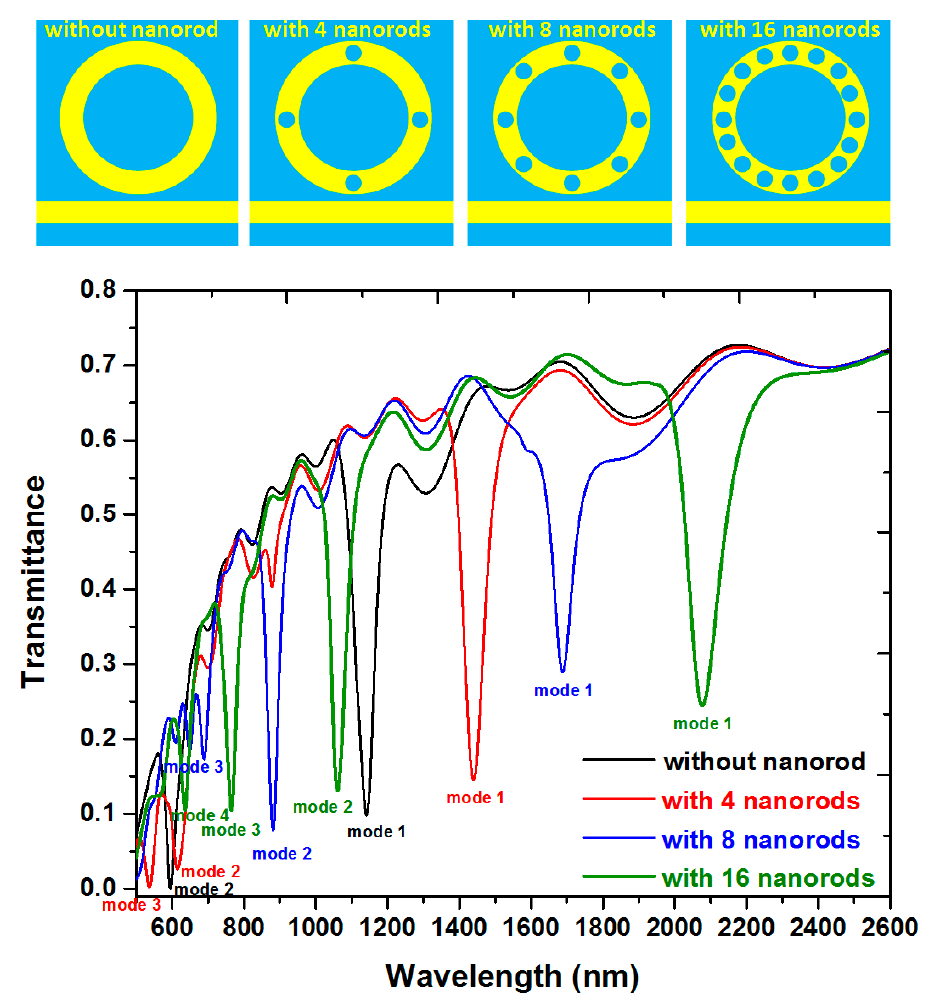
Figure 2. Transmittance spectra of the proposed plasmonic band-stop filter without (black color) and with (red, blue, and olive colors) silver nanorods in the nanoring. The numbers of the silver nanorods are N = 0, 4, 8, and 16, respectively, as shown in the most upper panel of this figure. The other geometric parameters, w , h , R , and r , are set to be 50, 10, 100, and 20 nm, respectively. The transmittance dips found in Figure 2 are related to the strong absorption of light in the nanoring region due to the localized surface plasmon resonance (LSPR) [55–58] and cavity plasmon resonance (CPR) [59–61]. Figure 3a–d depicts the magnetic field and electric field intensities for the cases without silver nanorods (at λ res =1142 nm), with four silver nanorods (at λ res =1440 nm), with eight silver nanorods (at λ res =1680 nm), and with sixteen silver nanorods (at λ res =2072 nm) of mode 1, respectively. It is evident from Figure 3 that the confinement light at the corresponding λ res , i.e., SPPs are confirmed at the left side of the straight waveguide and the nanoring. The nanoring can be regarded as a Fabry-Perot cavity. The SPP is coupled to the nanoring well at λ res , and the transmittance of SPPs is prohibited. The SPPs are limited in the nanoring due to the destructive interference between the straight waveguide and nanoring. The |H| and |E| patterns show a standing wave profile of the cases without silver nanorods while exhibiting gap plasmon and edge plasmon enhancements on the surface of silver nanorods and nanoring of the cases with silver nanorods [62–65].